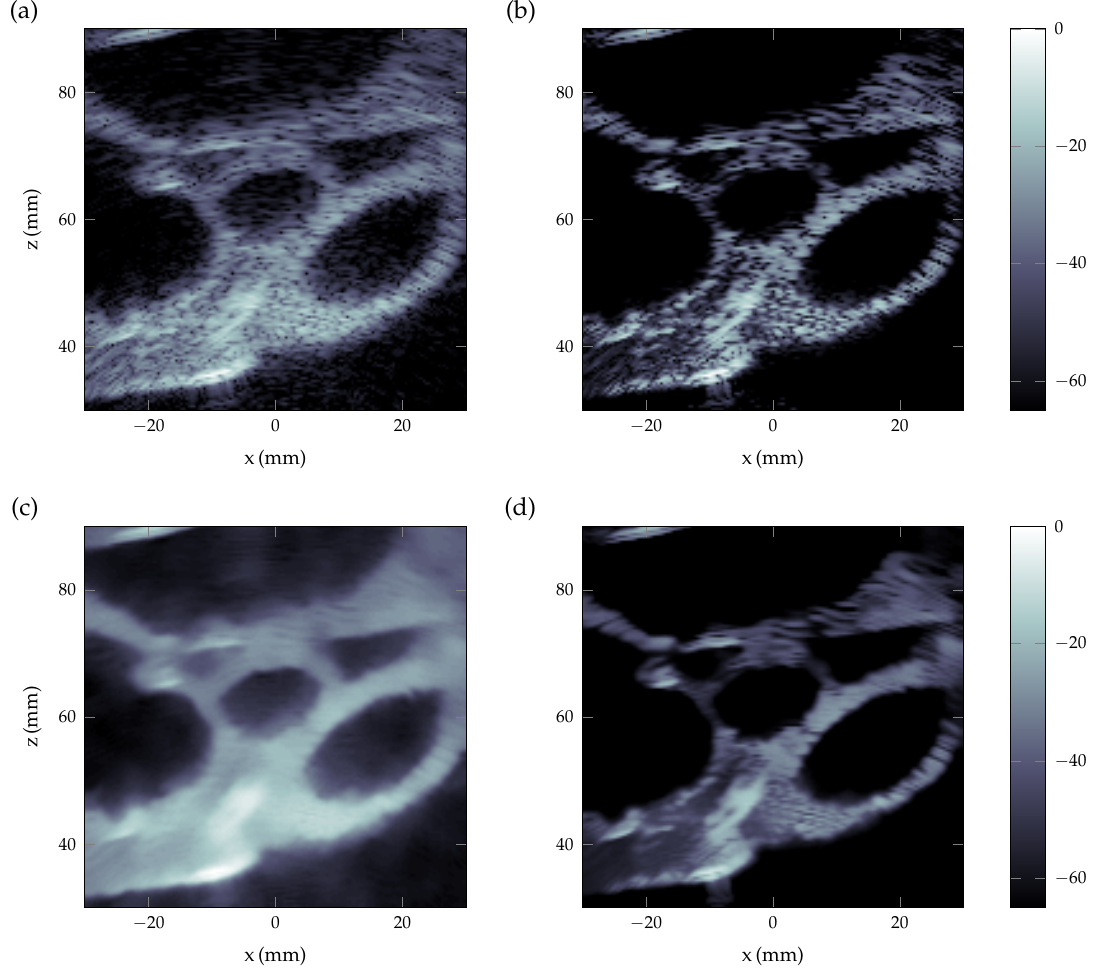
Figure 7. Heart phantom results: ( a )DAS, ( b )RiB(10%), ( c )NLmeans-DAS and ( d